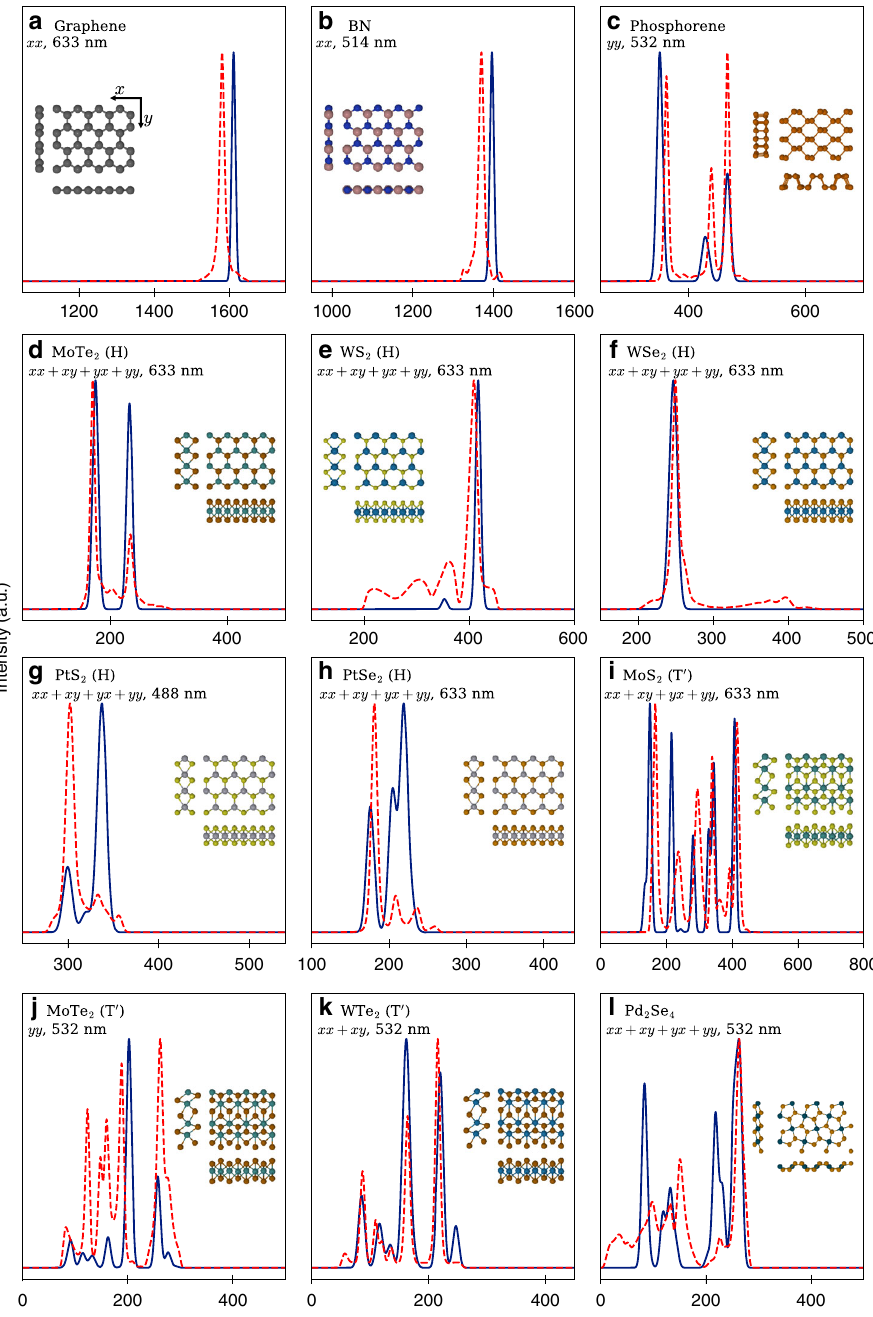
Fig. 5 Raman spectra of 12 monolayers. Comparison of computed Raman spectra (solid lines) with available experimental results (dashed lines). The experimental data are extracted from Refs. 23,69 – 79 , for (a) to (l), respectively. The temperature is set to 300 K (room temperature) and excitation wavelength is speci fi ed in each case, see the main text. The crystal structures are shown in the insets including top view and cross sectional views. For all crystal structures the x - and y -directions are along the horizontal and vertical directions, respectively, as shown for